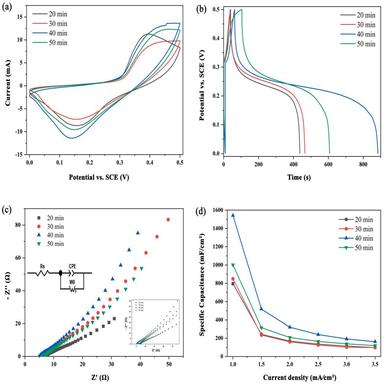
Electrochemical performance of CdSe deposition 20, 30, 40 and 50 min (a) CV curves at a scan rate of 100 mV/s, (b) GCD curves at a current density of 1 mA/ cm2 , (c) Nyquist plots (The insets are equivalent circuit diagrams and enlarged Nyquist curves respectively), and (d) specific capacitance line diagrams.